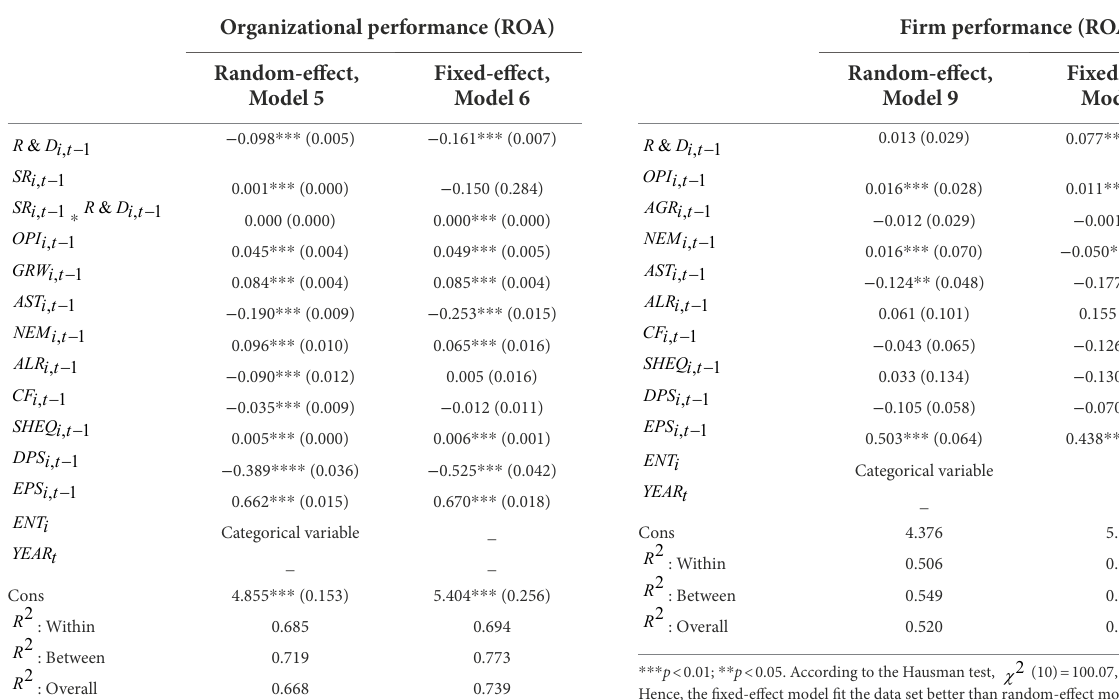
TABLE 5 Estimation results for moderating role of investor sentiment.